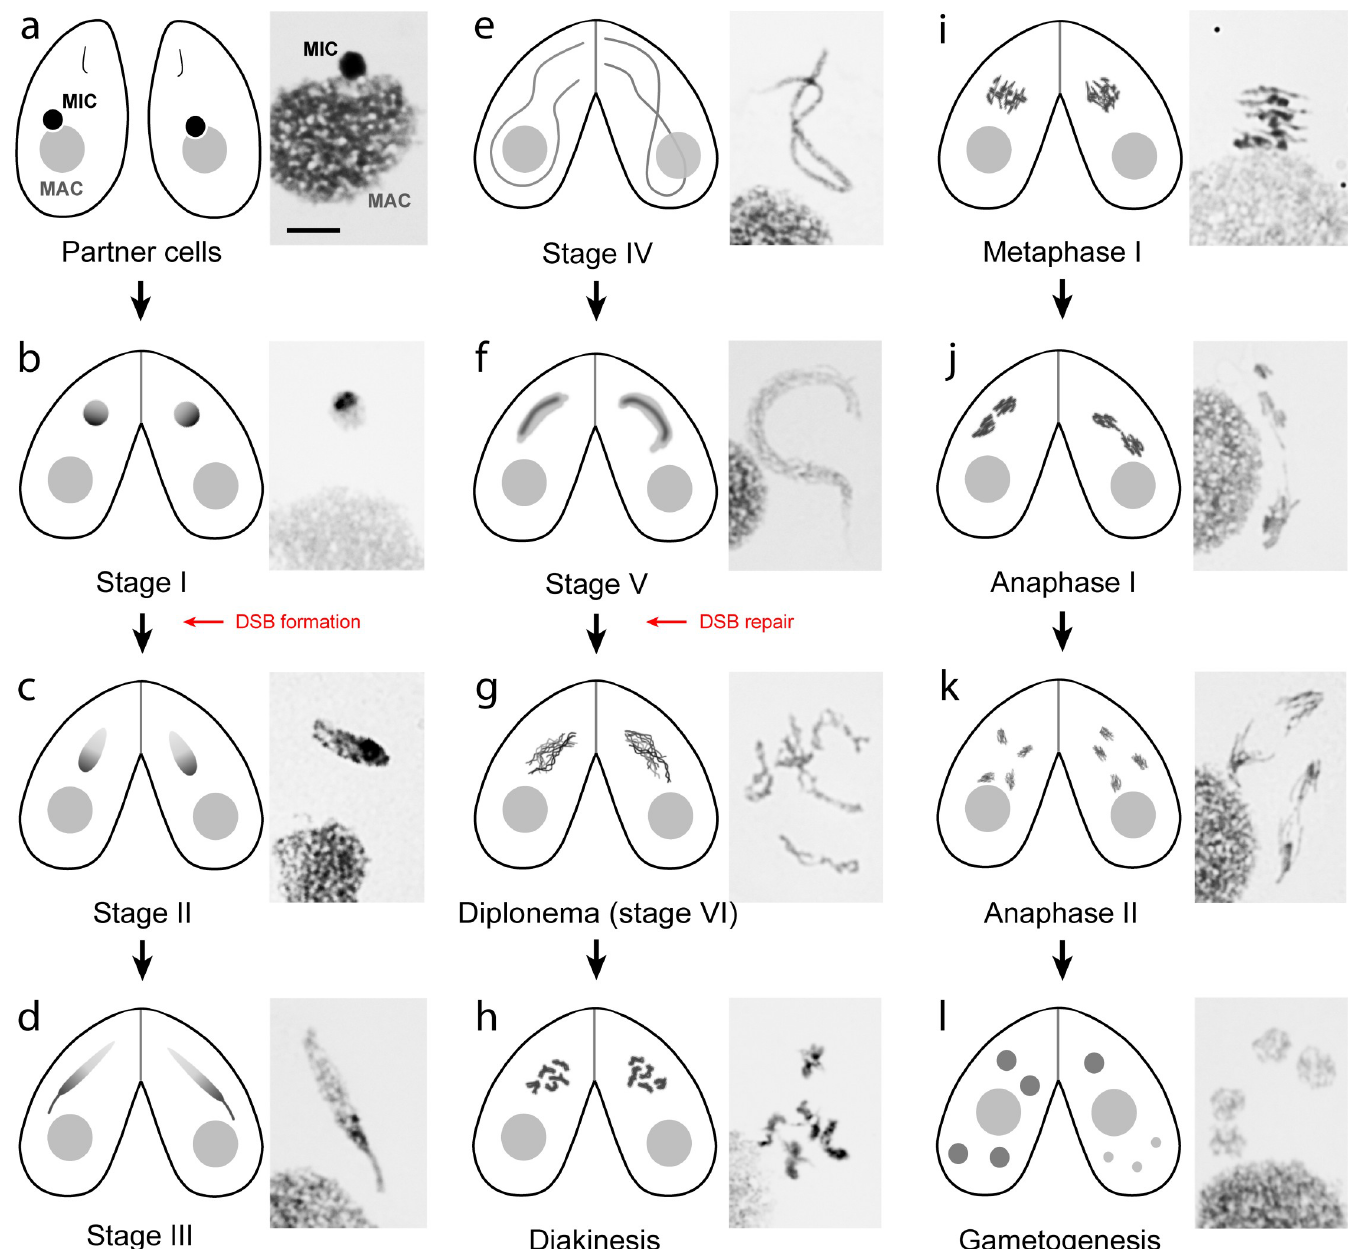
Fig 2. Tetrahymena meiotic stages. Schematic diagrams of mating cells and microscopy images of Giemsa-stained meiotic nuclei. Meiotic prophase is staged according to [79]. ( a) In nonmeiotic cells, the MIC is located in a pocket on the MAC surface. ( b) In stage I conjugating cells, the round MIC moves away from the MAC. The progress of meioses in conjugated cells is largely synchronous. ( c–e) Once DSBs begin to form, the MICs start stretching and elongate to about twice the length of the cell. ( f) MICs then shorten, and all DSBs are repaired by the end of stage V. ( g) Progressive chromatin compaction reveals the formation of 5 bivalents. ( h) Bivalents with protruding centromeres have reached maximal condensation. ( i) Bivalents arranged in a metaphase plate. ( j, k) Anaphase I and II follow the conventional scheme. ( l) After telophase II (left cell), one of the 4 meiotic products is selected to divide into 2 gametic nuclei, whereas the other 3 products degenerate (right cell). Bar: 10 μ m. DSB, double-strand break; MAC, macronucleus; MIC,